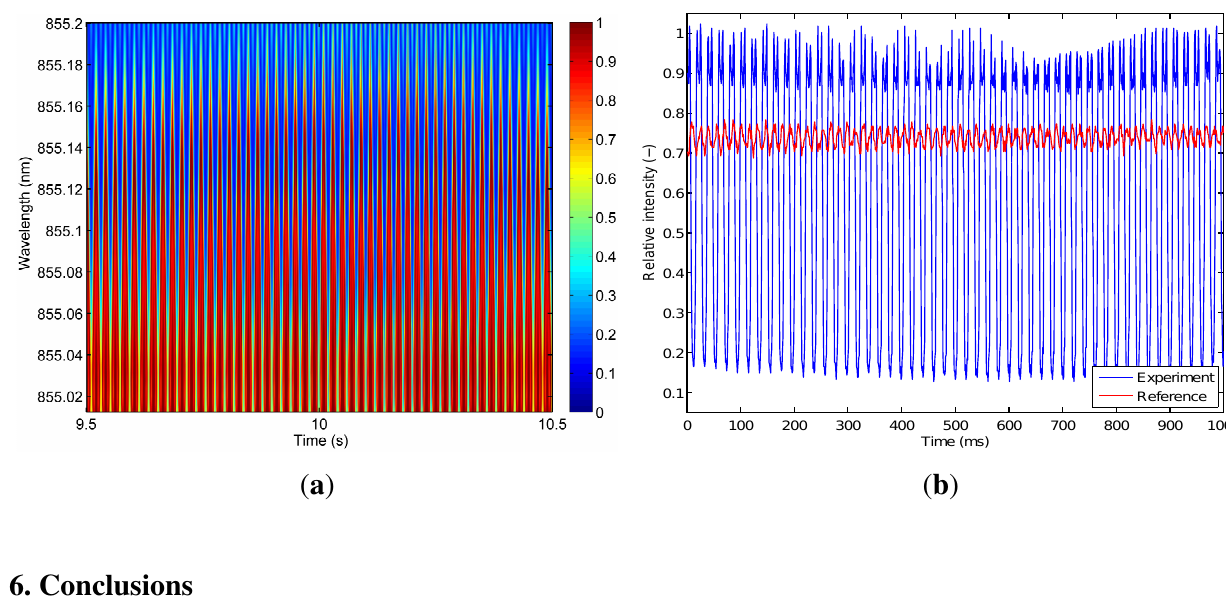
Figure 17. Detailed analysis of the electrodynamic shaker characterization (relative wavelength intensities). ( a ) Detailed view of the full spectral reconstruction; ( b ) Time domain analysis (intensity at a fixed wavelength of 855.104 nm) during